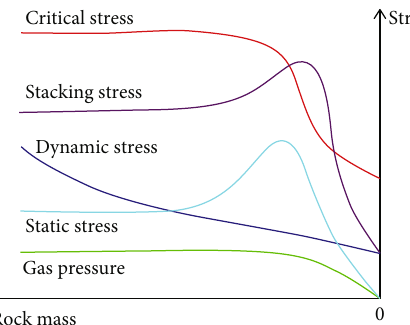
Figure 1: Critical condition of shock-type coal and gas outburst